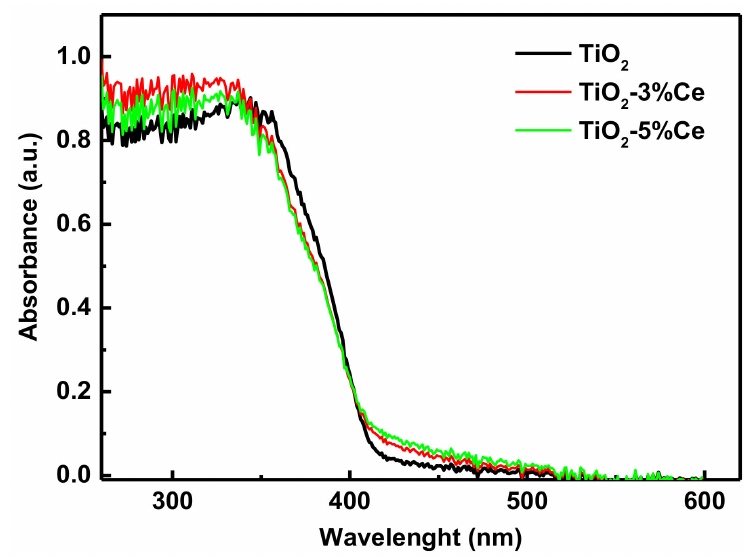
Figure 5. UV–Vis absorption of the fibrous TiO 2 and TiO 2 –xCe samples. We found the band gap of the samples under study by the Tauc method [33] to be 3.16 ± 0.1, 3.15 ± 0.1, and 3.13 ± 0.1 eV for TiO 2 , TiO 2 –3% Ce and TiO 2 –5% Ce, respectively. So, the doping technique applied did not yield any statistically significant changes in the band